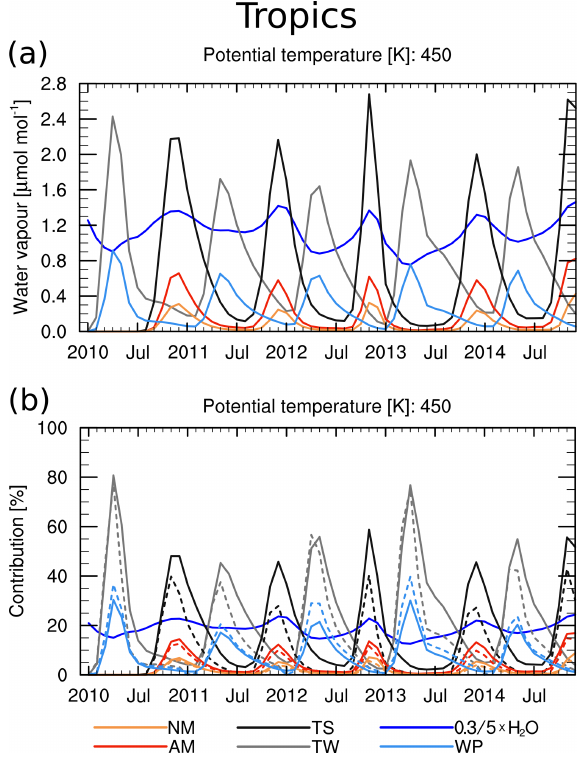
Figure 6. (a) Time series of the H 2 O mean mixing ratios from the different source regions and water vapour (all in µmolmol − 1 , to- tal H 2 O scaled by × 0 . 3 to fit the same scale as the regional trac- ers). The time series were calculated over the region 10 ◦ S–10 ◦ N at 450K for the source regions TS (black), TW (grey), WP (light blue), AM (red) and NM (orange). Total water is shown in dark blue. (b) Time series of the percentage contribution of the mass (dashed) and H 2 O (solid) tracers for the different source regions averaged over 10 ◦ S–10 ◦ N at 450K (total H 2 O scaled by × 5, where 1% equals 1µmolmol − 1 ). Colour coding as in (a) .